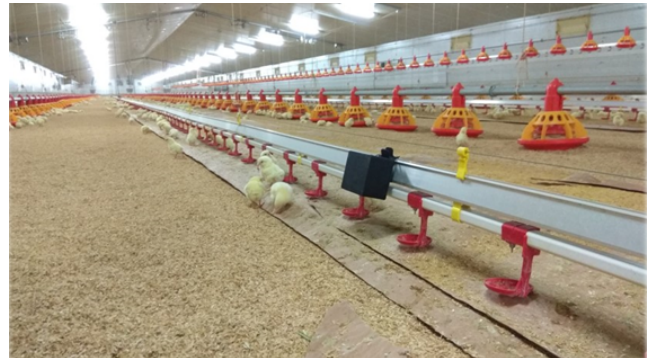
Figure 4. Real-world poultry farm used for demonstration